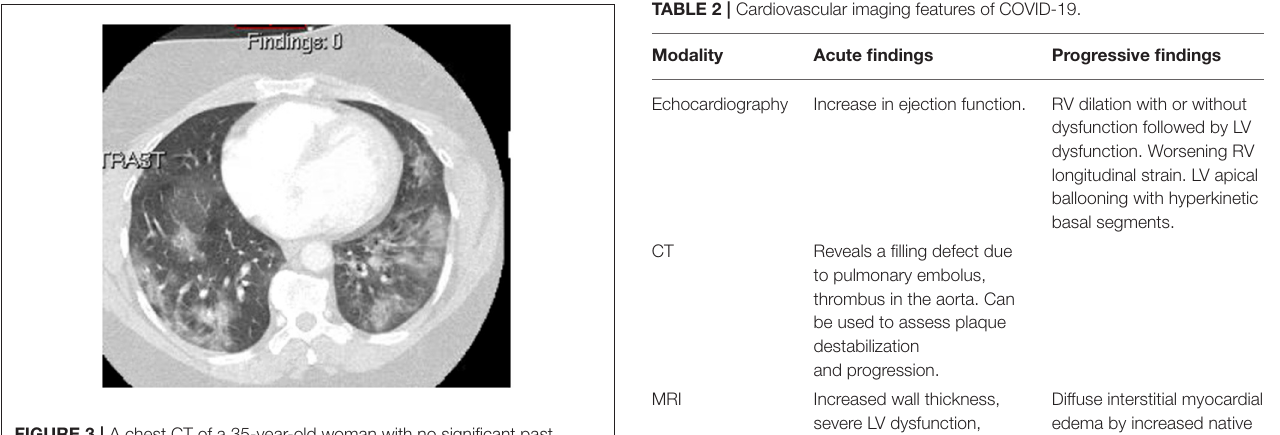
FIGURE 3 | A chest CT of a 35-year-old woman with no significant past medical history presenting with progressive dyspnea, chest pain, and hemoptysis showing typical ground-glass opacities and consolidation, which is seen in COVID-19. The patient was confirmed of COVID-19 with PCR testing.